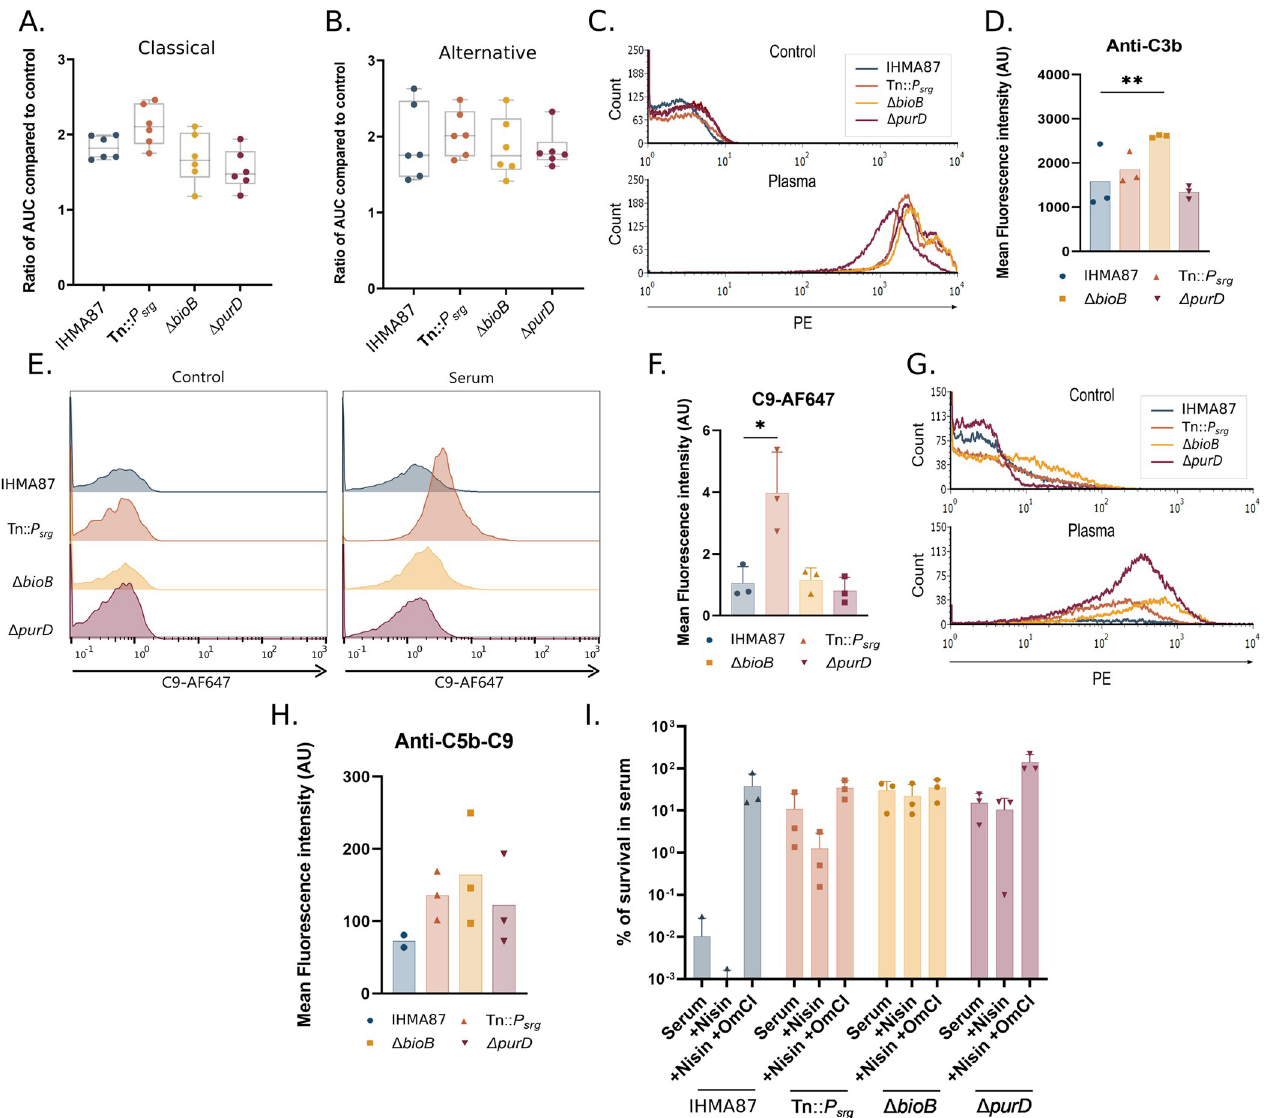
Fig 7. Mutants’ response to MAC-dependent killing. Residual complement activity of the classical ( A. ) and alternative ( B. ) complement pathways was measured after bacterial challenge in plasma, using lysis kinetics of erythrocytes, as described in Materials and Methods. Area under the curve (AUC) values were determined for each series and expressed relative to the 90% plasma pool control. n = 3. C. C3b deposition on bacterial surface after incubation for 15 min in 0% (Control) or 90% plasma. Deposition was determined by FACS using the C3b specific PE-labeled antibody. D. Mean fluorescence intensities of the plasma condition presented in C. n = 3. �� p -value < 0.001. E. C9-AF647 insertion into bacterial membrane after 30 min in 0% (Control) or 3% pooled human serum and F. mean fluorescence intensities ( � p -value < 0.05). G. C5b-9 deposition on bacterial surface after 15 min incubation in 0% (Control) and 90% plasma. Deposition was determined by FACS; mean fluorescence intensities are plotted ( H. ). n = 3. I. Bacterial survival in pooled human serum or in the presence of nisin with or without the complement inhibitor